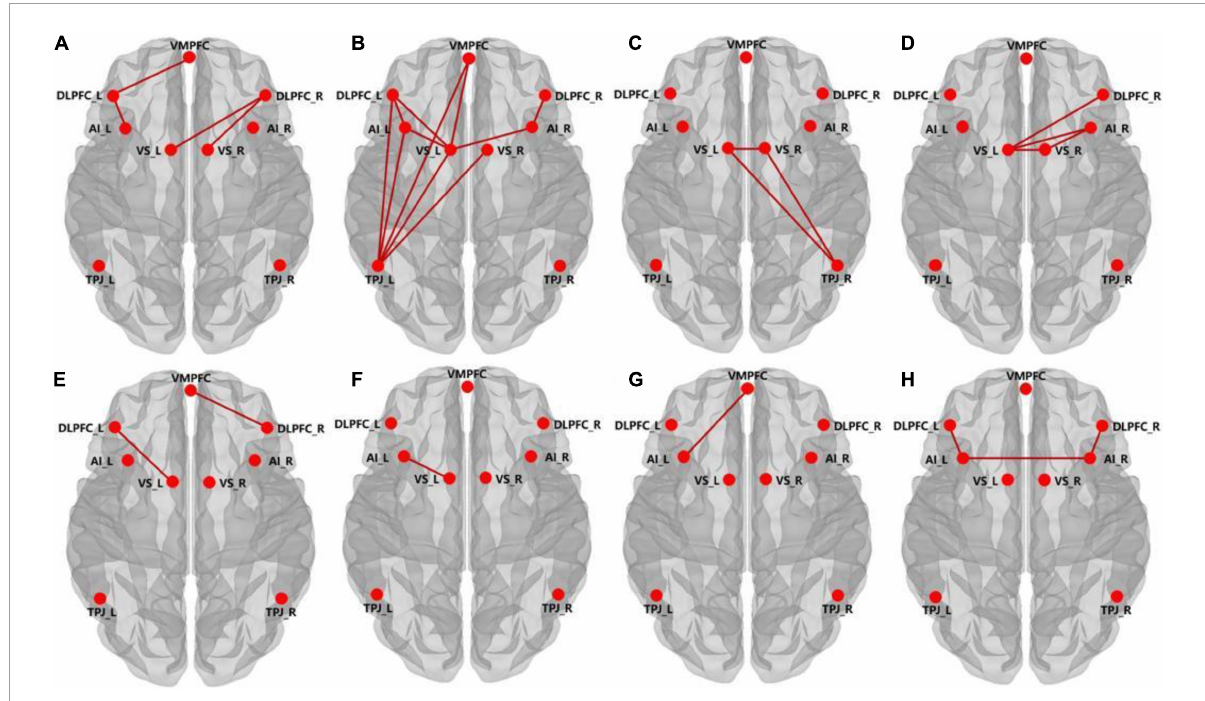
FIGURE3 Panels (A,B) show the increased functional connectivities in the music group compared to the no sound group before accepting the unfair offers of 3 and 4. Panels (C,D) show the increased functional connectivities in the music group compared to the no sound group before rejecting the unfair offers of 3 and 4. Panels (E,F) show the increased functional connectivity in the music group compared to the no sound group when accepting the unfair offers of 3 and 4. Panels (G,H) show the increased functional connectivity in the music group compared to the no sound group when rejecting the unfair offers of 3 and 4. (Independent samples t -tests, all P s < 0.05). Abbreviations of ROIs: VMPFC, ventral medial prefrontal cortex; DLPFC_L, left dorsolateral prefrontal cortex; DLPFC_R, right dorsolateral prefrontal cortex; VS_L, left ventral striatum; VS_R, right ventral striatum; AI_L, left anterior insula; AI_R, right anterior insula; TPJ_L, left temporoparietal junction; TPJ_R, right temporoparietal junction.